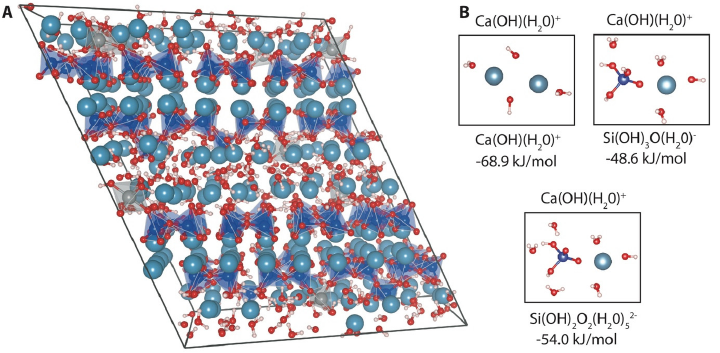
Figure 4. A bulk atomic ‐ level structure of aluminum incorporated C ‐ S ‐ H is shown in (A), taken from [73], copyright 2020 American Chemical Society. Free energy of complexation of a few early age hydration species in solution are shown in (B), adapted from [79]. Atomic color codes are oxygen: red, hydrogen: white, calcium: tourqois, silicon: blue, aluminum: